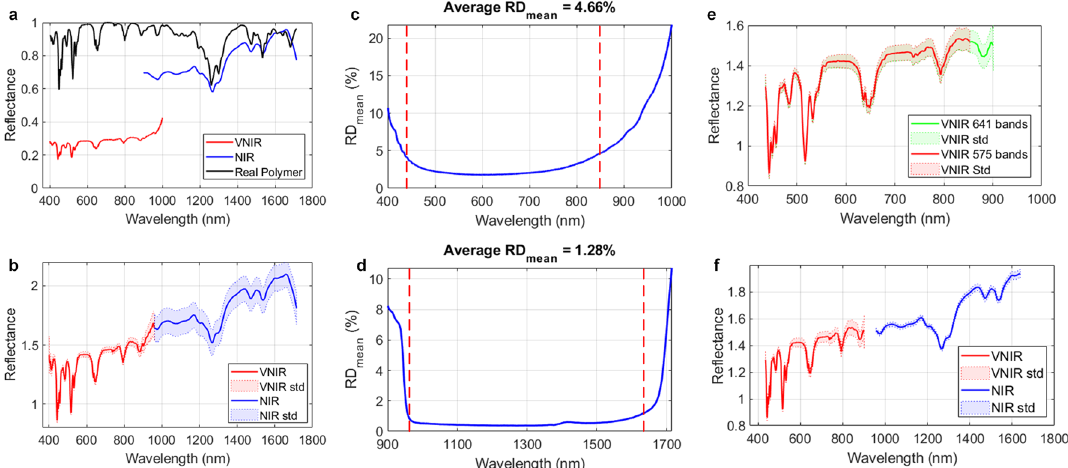
Figure 2. ( a ) Manufactured certified spectral signature of the Zenith Polymer and spectral signatures captured by the VNIR and NIR cameras. ( b ) Fused spectral signature using a common spectral band in the overlapped spectral region between VNIR and NIR data. ( c , d ) Average absolute relative difference percentage (RD) results of SR1 using VNIR and NIR data. Red dashed lines represent the initial and final cutoff points for voiding the low performance of the HS sensors. ( e ) Comparison between the mean and std of the Zenith Polymer VNIR spectral signature with 641 spectral bands (green) and 575 spectral bands (red). (f) Fused spectral signature of the Zenith Polymer after applying the proposed VNIR–NIR spectral fusion